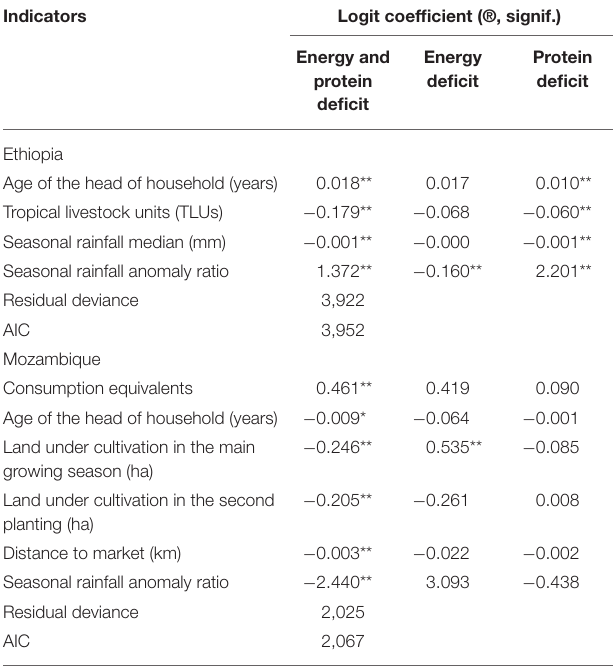
TABLE 1 | Change in the log odds of a food deficit with household- and environment-level factors in Ethiopia and Mozambique. Indicators Logit coefficient (®, signif.)